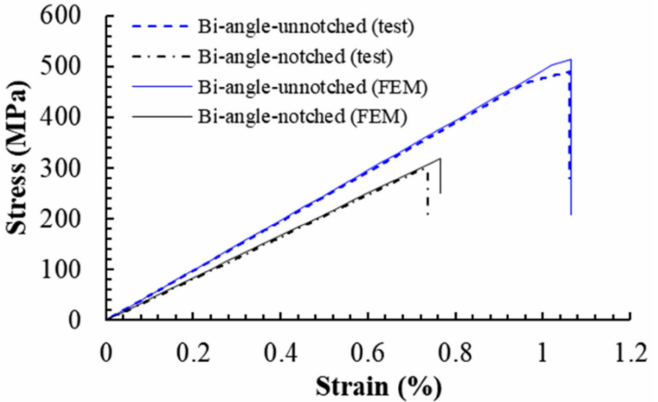
Figure 10. ( a ) The propagation of delamination between the 0 ◦ ply and 45 ◦ ply with the increase of load from simulation. ( b ) The damage image of the interface 1 at the load of 7.7 kN.